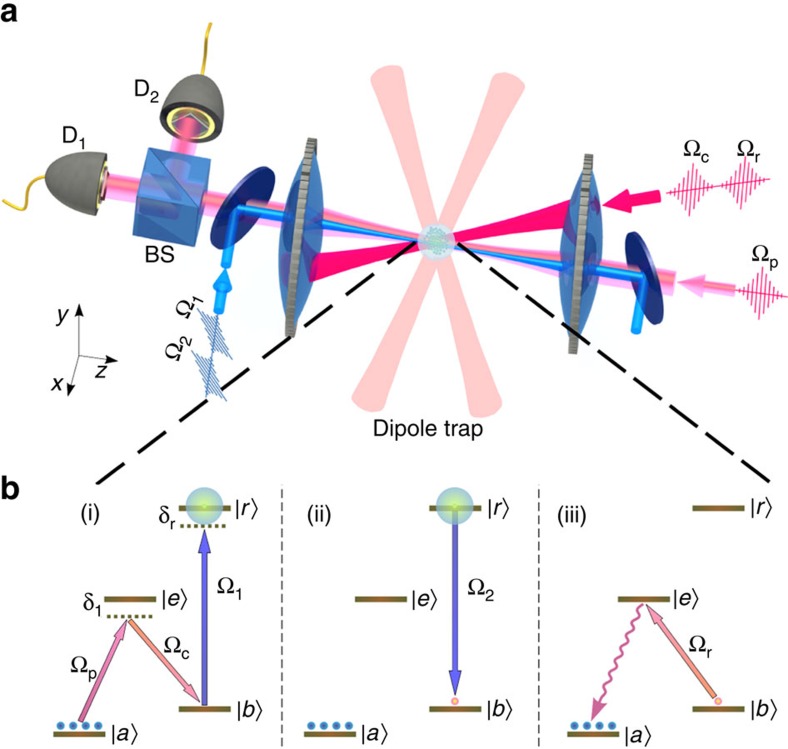
Overview of the experiment.(a) Essential elements of the experimental set-up. An ultra-cold 87Rb gas is confined in a crossed dipole trap formed by two 1,064 nm fields. Two 795 nm beams (probe and control) and a 297 nm beam are focused on the atomic sample with waists (ωp, ωc, ω1,2)=(5, 25, 18) μm, respectively. The probe and control beam are aligned with an angle 3°, while the 297 beam counter propagates with the probe beam. Probe Ωp and control Ωc laser fields are orthogonally circularly polarized. To avoid the dephasing of Rydberg state induced by inhomogeneous light shifts, the dipole trap is turned off before the Rydberg excitation field Ω1 and switched back on after the Rydberg transfer field Ω2. (b) Level diagram and experimental protocol. (i) Atoms are initially prepared in state |a> by means of optical pumping. The atomic ensemble is driven from |a> to |b> by the probe field Ωp and control field Ωc. Next, the 297 nm field Ω1 couples |b> directly to the Rydberg state |r>, creating a singly excited Rydberg state. (ii) By applying the 297 nm field Ω2, the short-lived Rydberg excitation is mapped into the ground state |b> for storage. (iii) The ground-state excitation is retrieved by the read field Ωr and measured at D1 and D2. The atomic levels involved are |a>=|5s1/2, F=1, mF=0>, |b>=|5s1/2, F=2, mF=−2>, |e>=|5p1/2, F=1, mF=−1> and |r>=|np3/2, mJ=−3/2>.